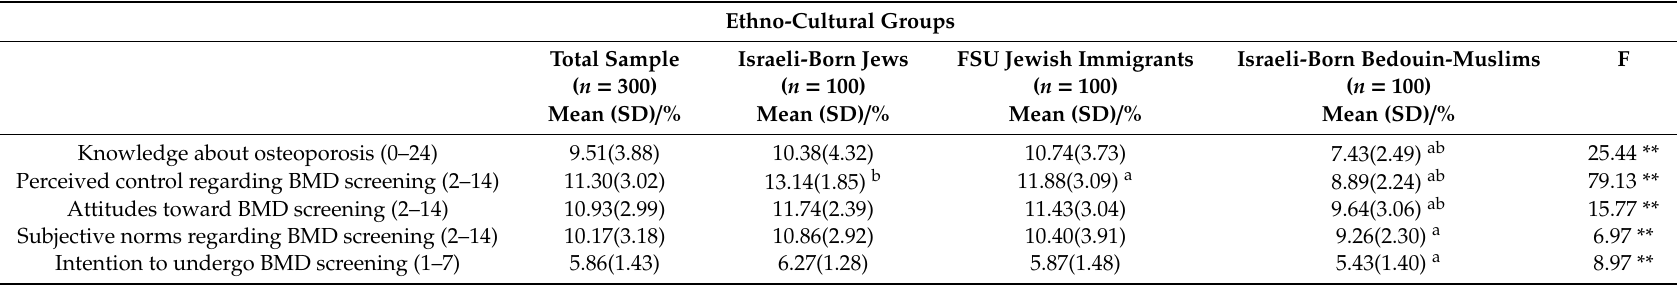
Table 2. Di ff erences in knowledge about osteoporosis and theory of planned behavior (TPB) components by ethnicity (ANOVA). BMD—bone mineral